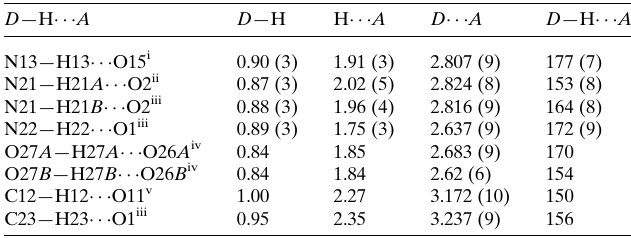
Table 1 Hydrogen-bond geometry (A˚ , (cid:3) ) for